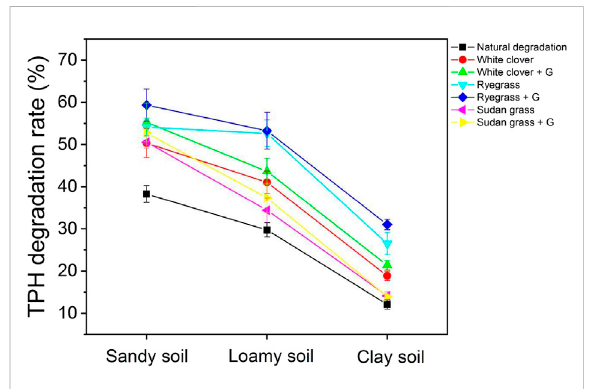
FIGURE 7 Degradation rate of total petroleum hydrocarbons under different soil conditions. G represents for 1000 mg kg − 1 of